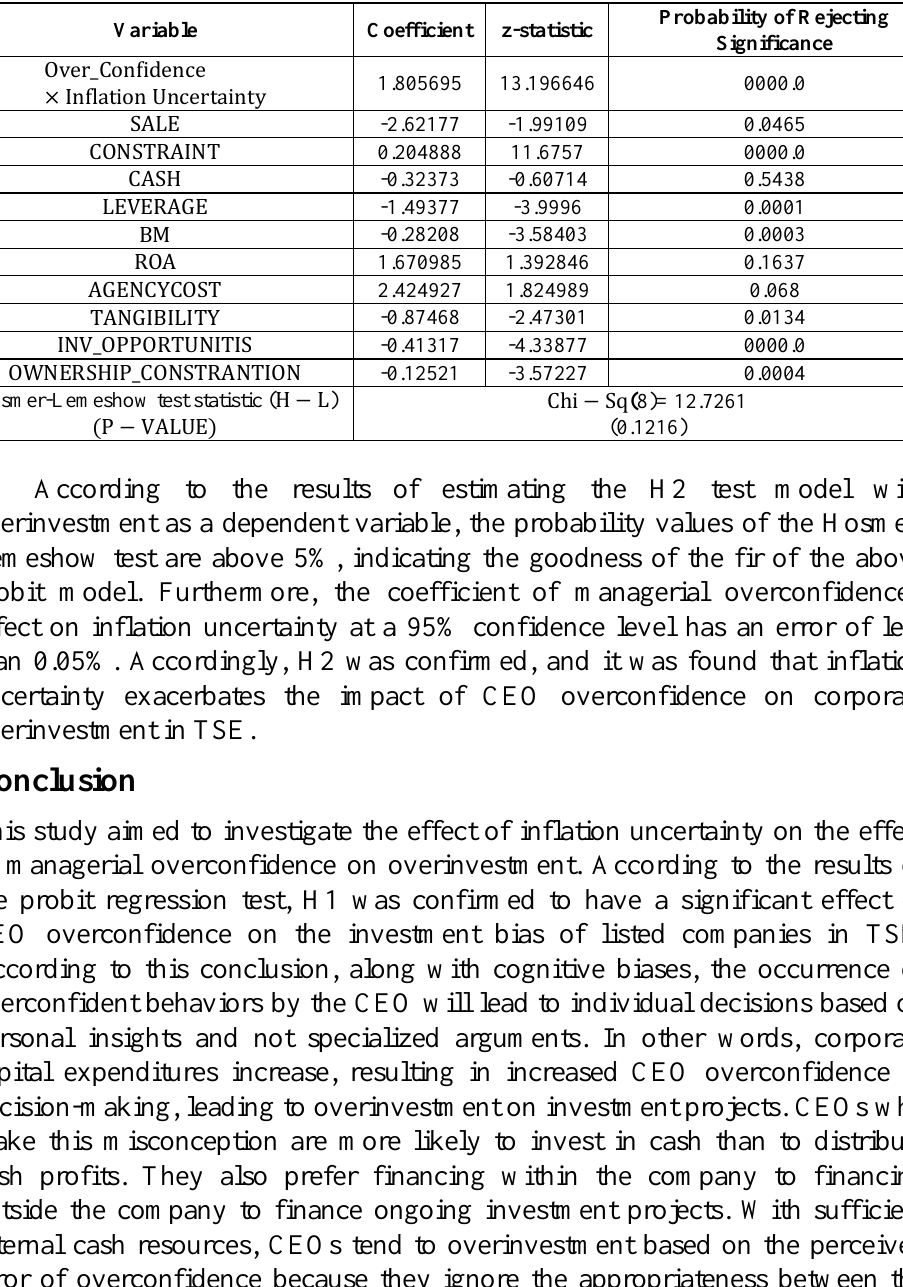
Table 5. Estimation results by probit method (dependent variable: corporate